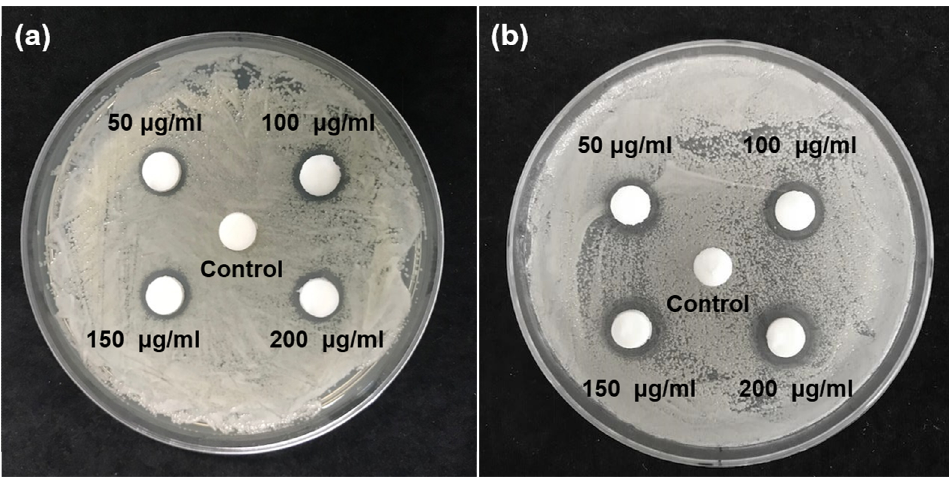
Figure 1. Inhibition zones of di ff erent concentrations (50 µ g / mL, 100 µ g / mL, 150 µ g / mL, and 200 µ g / mL) of Glycyrrhiza uralensis extract on agar plates of ( a ) Streptococcus mutans and ( b ) Candida albicans